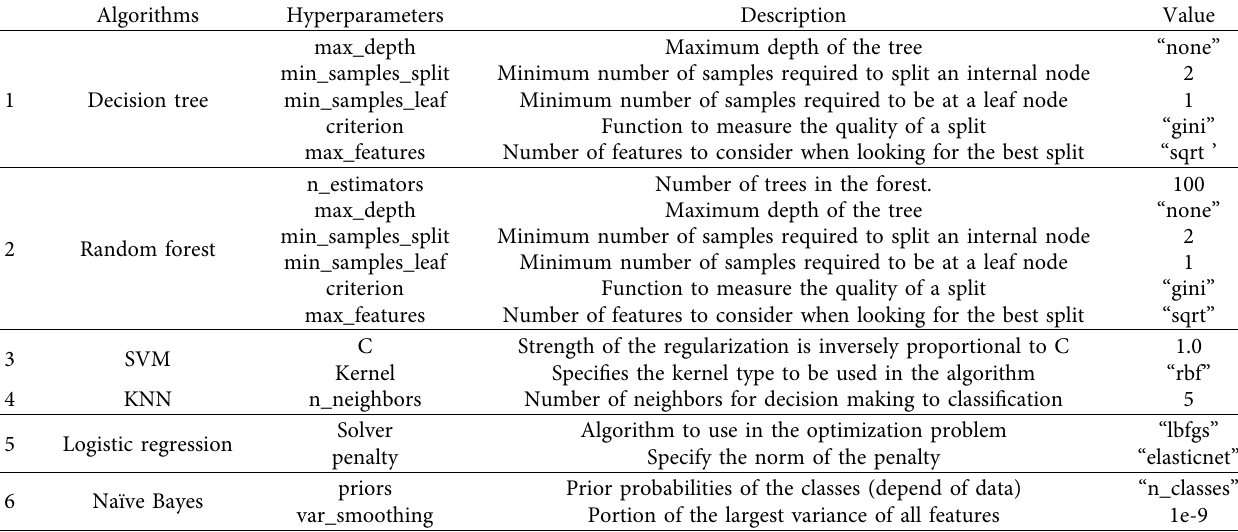
Table 7: Hyperparameters of classification algorithms.